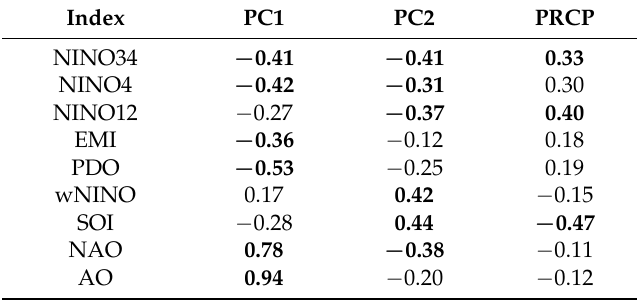
Table 3. Forty-one-year correlation coefficients of PC1, PC2, and PRCP with various oceanic and atmospheric indices. Bolds are statistically significant correlations at the 95% confidence level.